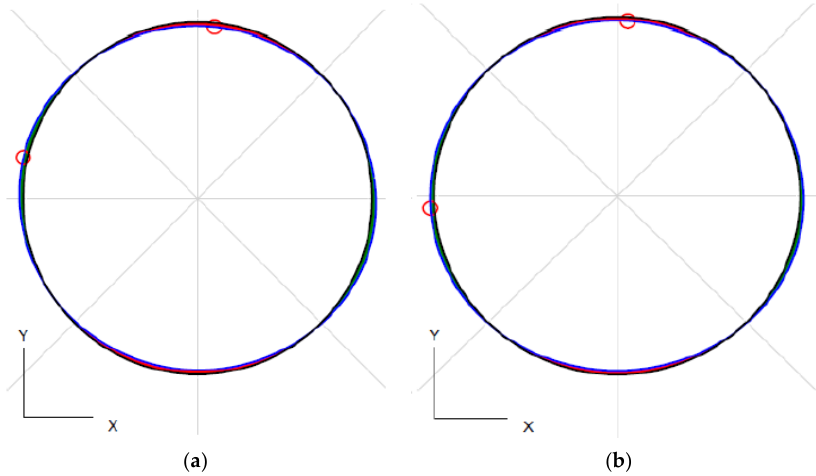
Figure 15. Roundness deviations ( a ) constant Z strategy; ( b ) circular pocket strategy.